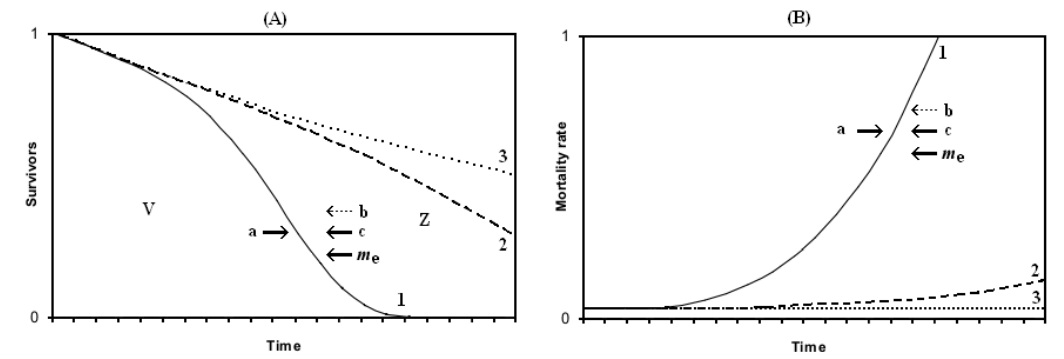
FIGURE 4 . Adaptive hypothesis. The curves are the same as in Fig. 1. (A) The life table of an IMICAW species (Curve 1) is influenced by [a] = selection against ML-limiting factors; [c] = hypothesized advantage of the IMICAW phenomenon causing intrinsic mortality [ m i ]; [ m e ] extrinsic mortality (= m 0 + m w ); while [b] = ML-limiting harmful factors (see nonadaptive hypothesis) is considered negligible (dashed line). (B) Mortality rates are influenced by the same factors as in Fig.